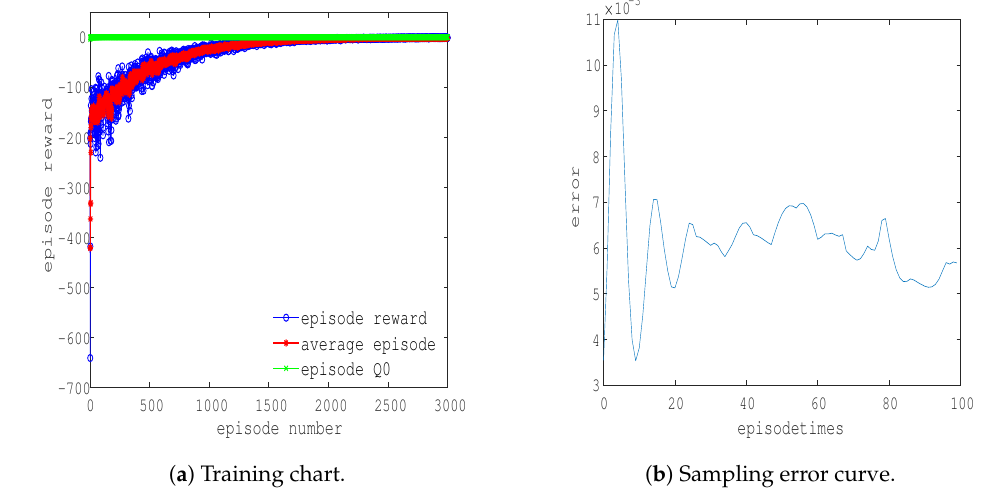
Figure 15. The third group of